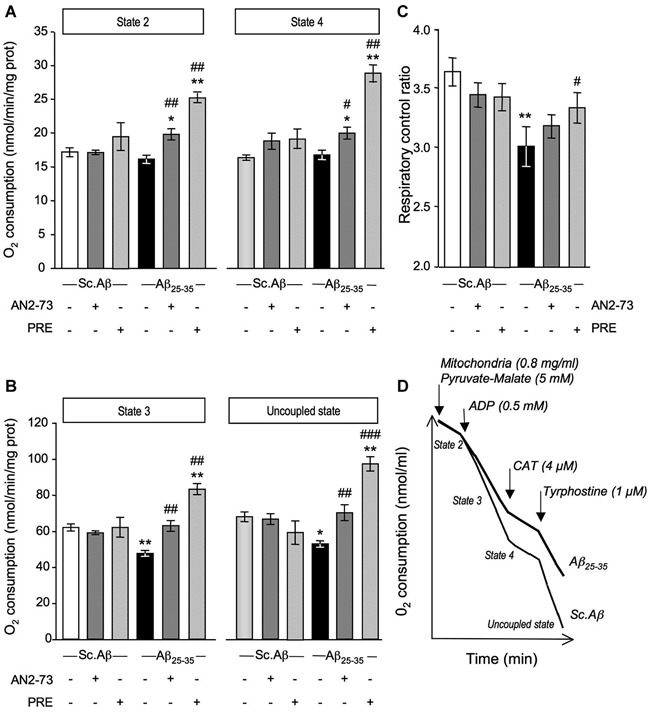
ANAVEX2-73 (AN2-73) and PRE-084 (PRE) protected against Aβ25–35-induced alteration of mitochondrial respiration in mice. Mice were treated with ANAVEX2-73 (0.3 mg/kg IP), PRE-084 (0.5 mg/kg IP) or vehicle, before injection of Sc. Aβ or Aβ25–35 (9 nmol ICV). (A–C) Mitochondria (0.8 mg/ml) were loaded in the chamber with appropriate buffer at 30°C. State 2 respiration was activated by addition of pyruvate-malate (5 mM). State 3 respiration was induced with ADP. State 4 respiration was provoked by the addition of carboxyatractyloside (CAT), a blocker of ATP-ADP carrier. Finally, addition of tyrphostine, an uncoupling agent, activated the uncoupled respiration. The respiratory control ratio is the state 3/state 4 ratio. n = 4–8 per group, F(5,38) = 7.11, p < 0.0001 for state 2 and F(5,38) = 8.43, p < 0.0001 for state 4 in (A); F(5,38) = 13.1, p < 0.0001 for state 3 and F(5,38)= 8.43, p < 0.0001 for state 3 in (B); F(5,38) = 2.58, p < 0.05 in (C). *p < 0.05, **p < 0.01 vs. Sc. Aβ/Veh; #p < 0.05, ##p < 0.01, ###p < 0.001 vs. Aβ25–35/Veh. Dunnett’s test. (D) Typical trace of O2 consumption for Sc. Aβ and Aβ25–35-injected mice.